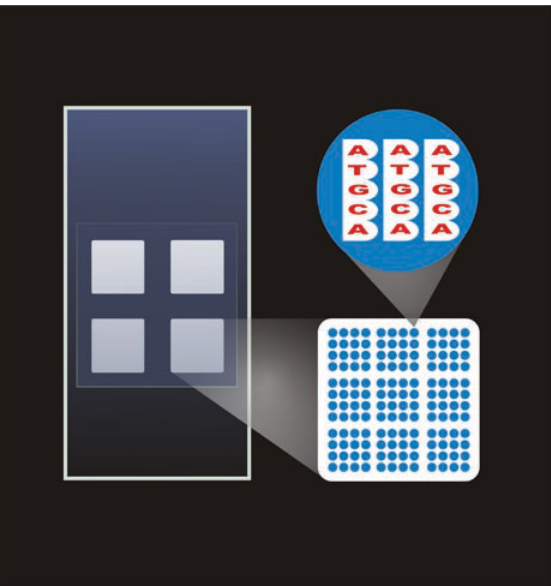
Figure 1. The chip